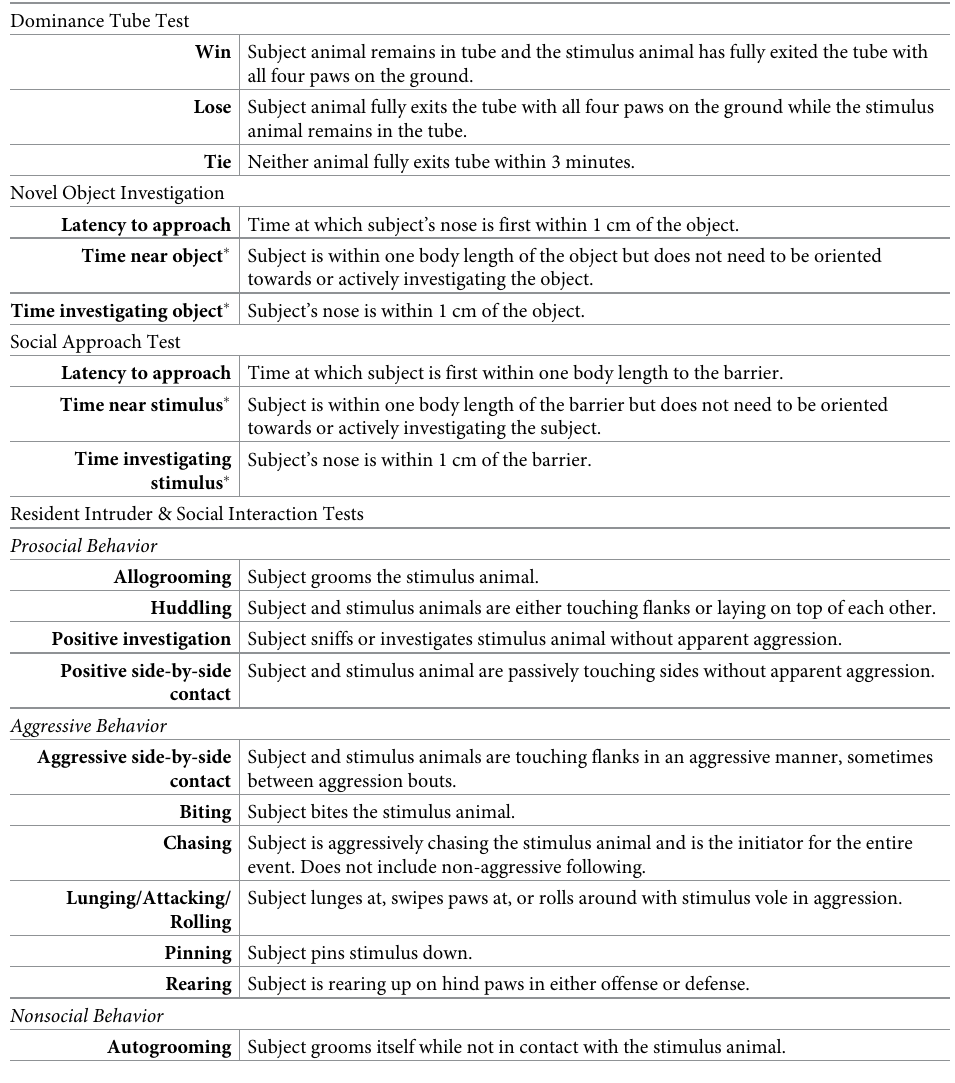
Table 1. Ethograms for behavioral assays. Dominance Tube